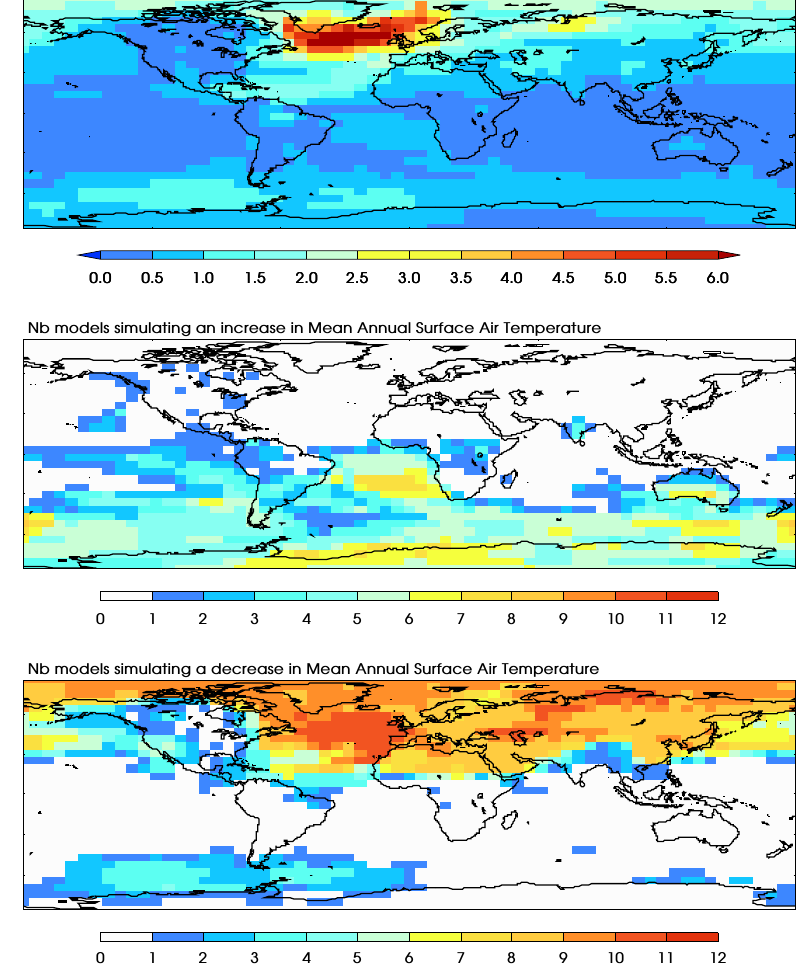
Fig. 3. (top) Standard deviation of the mean annual temperature responses to fresh water hosing simulated in the 11 hosing experiments (in K); (middle) number of models showing an increase larger than 0.5K between the perturbed and the reference experiments; (bottom) number of models showing a decrease larger than 0.5K (in amplitude) between the perturbed and the reference